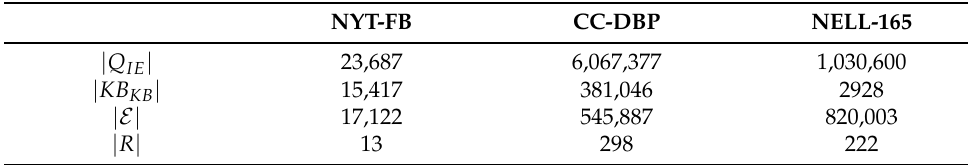
Table 1. Knowledge base population dataset statistics.